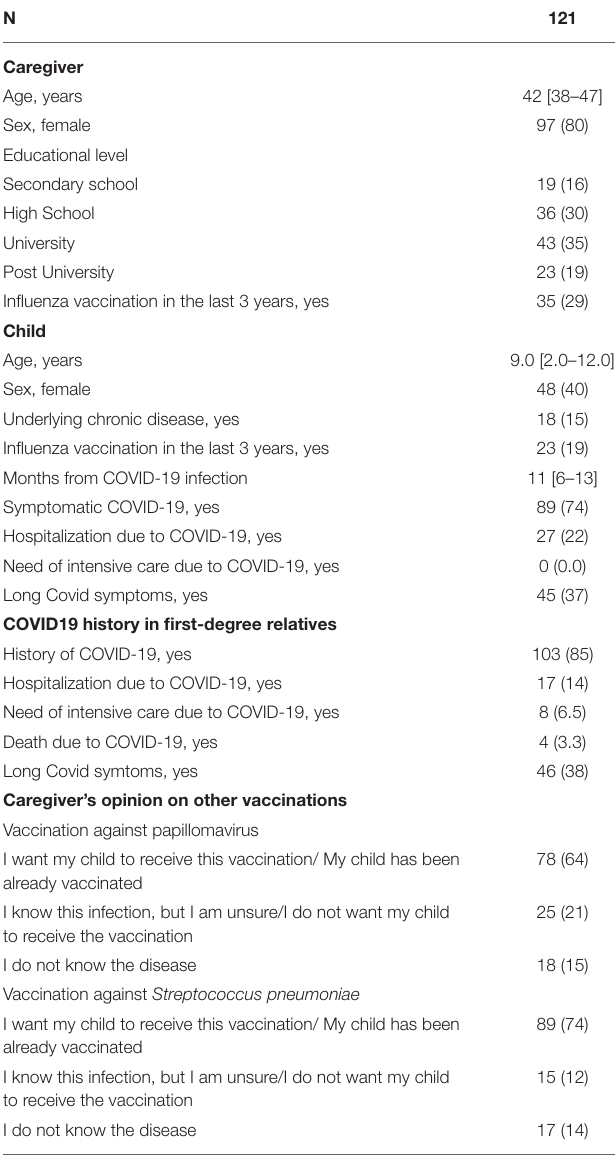
Table 1 . The majority had a university or post university degree ( N = 66, 54%). The median age of their child was 9.0 [2.0– 12.0] years (males = 73, 60%). Most respondents ( N = 103, 85%) had at least one relative with a history of COVID-19.